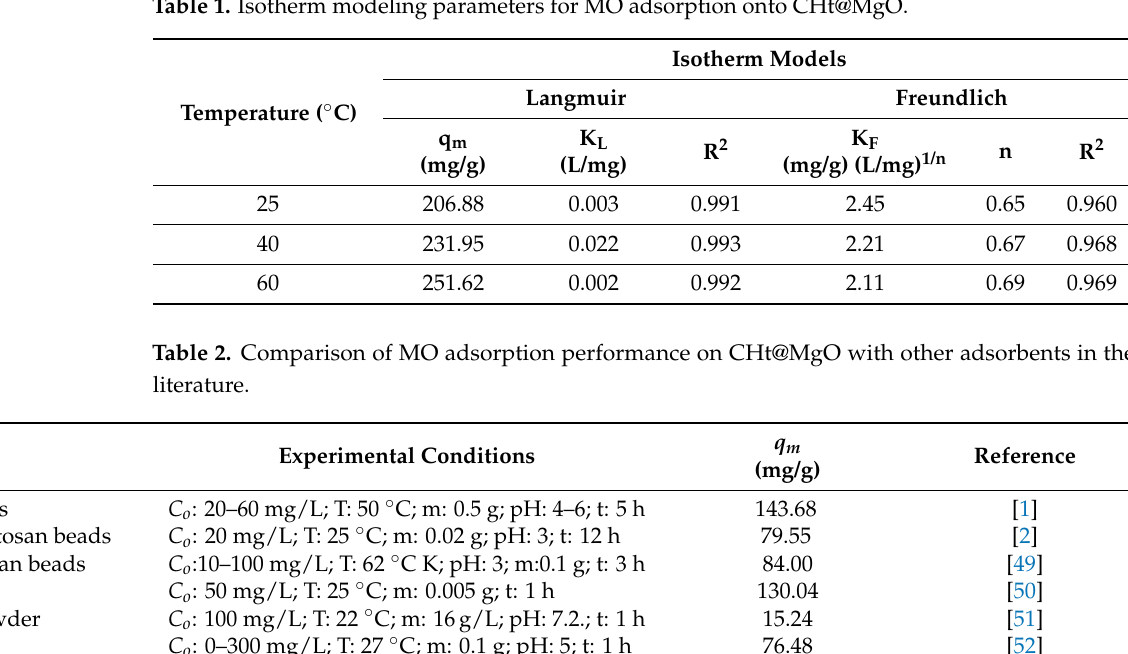
Table 1. Isotherm modeling parameters for MO adsorption onto CHt@MgO.